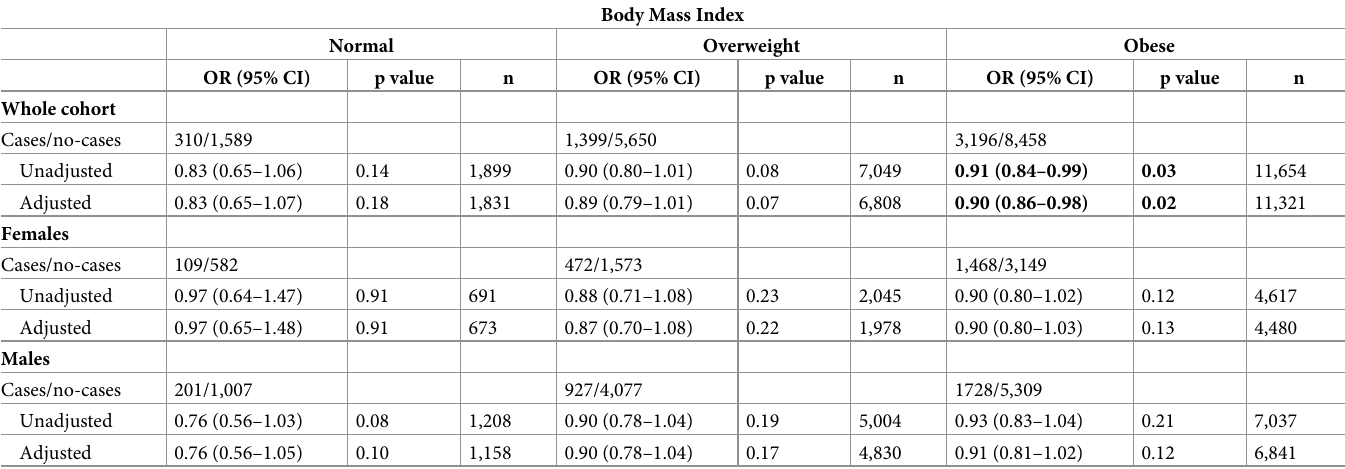
Table 3. Association between metformin and back pain considering body mass index